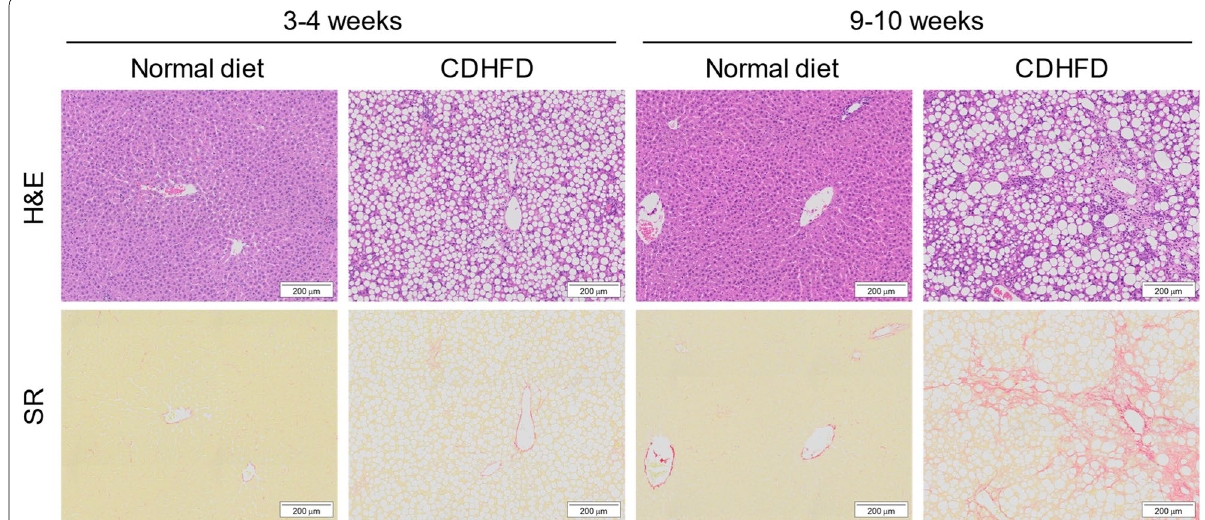
Values are expressed as means SDs ( n 5). * P < 0.05, ** P < 0.01, compared with the respective normal diet-fed group ± = CDHFD choline-deficient, low-methionine high-fat diet, AST aspartate aminotransferase, ALT alanine aminotransferase, TC total cholesterol, TG triglyceride, GLU glucose, TBA total bile acids, ALB albumin, ALP alkaline phosphatase, T-BIL total bilirubin